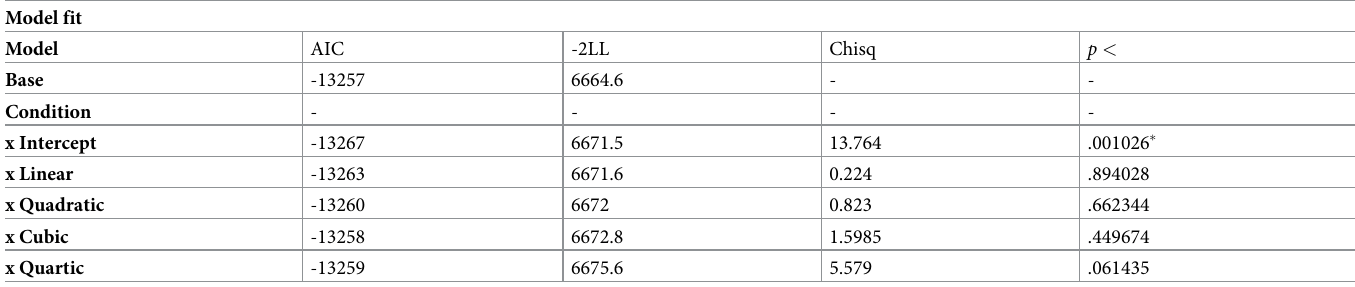
Table 5. Analysis of the goodness of fit of the model in the post-verb frame. Model fit